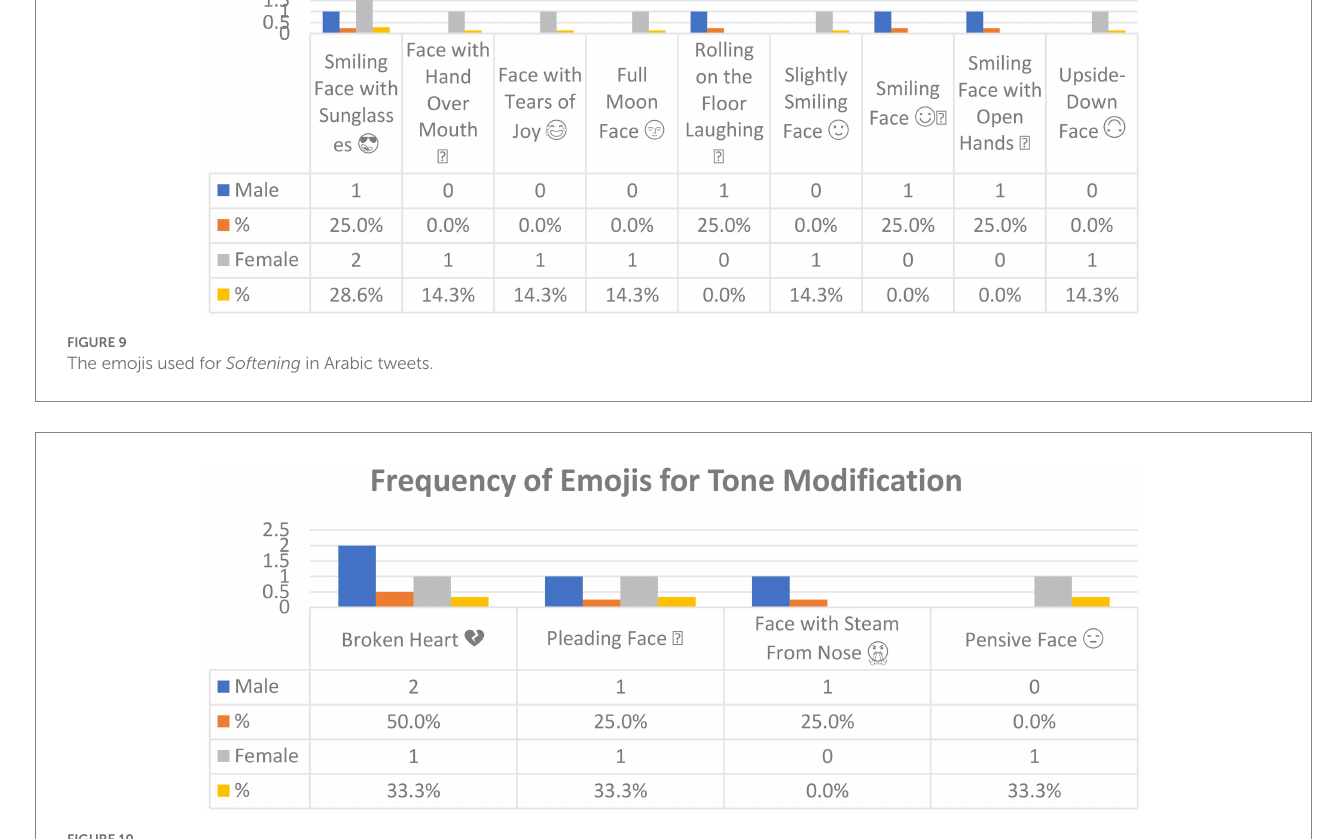
FIGURE 10 The emojis used for tone modification in Arabic